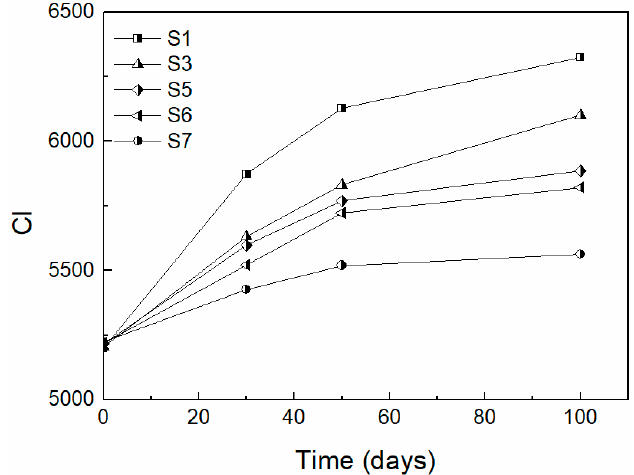
Figure 4. Carbonyl index vs time of aging for high-density polyethylene (HDPE) as a reference, and PCMs with 50 wt% of paraffin wax (PW).